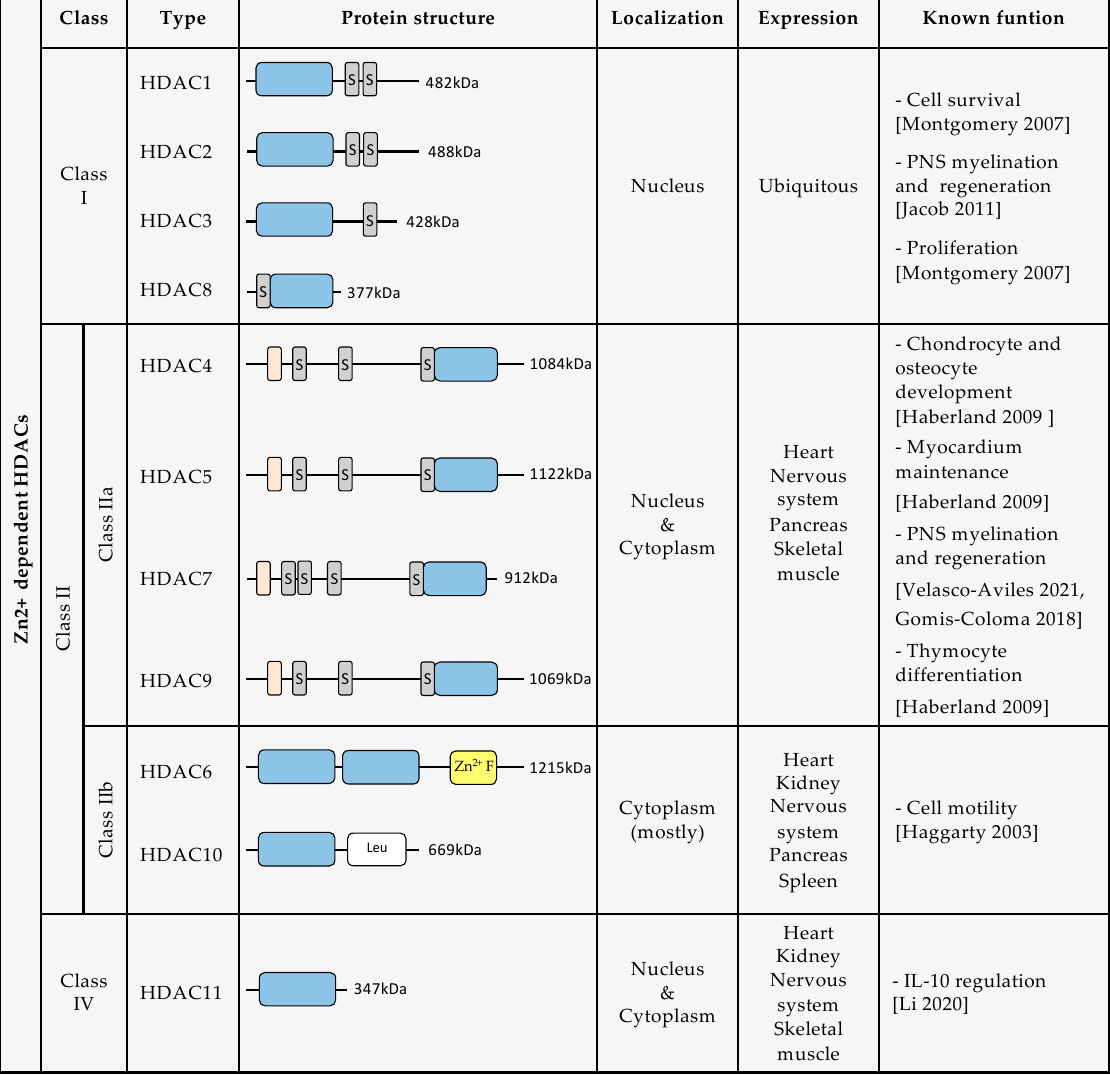
Figure 1. Description of protein structure, localization, expression, and known biological functions of Zn 2+ dependent HDACs [4,6,13–17]. (Dark grey rectangles containing an S indicate serine residues. Orange rectangles indicate a MEF2 binding site. Blue rectangles indicate the deacetylase domain. Yellow rectangle indicates a Zn 2+ finger. White rectangle indicates leucine rich domain).